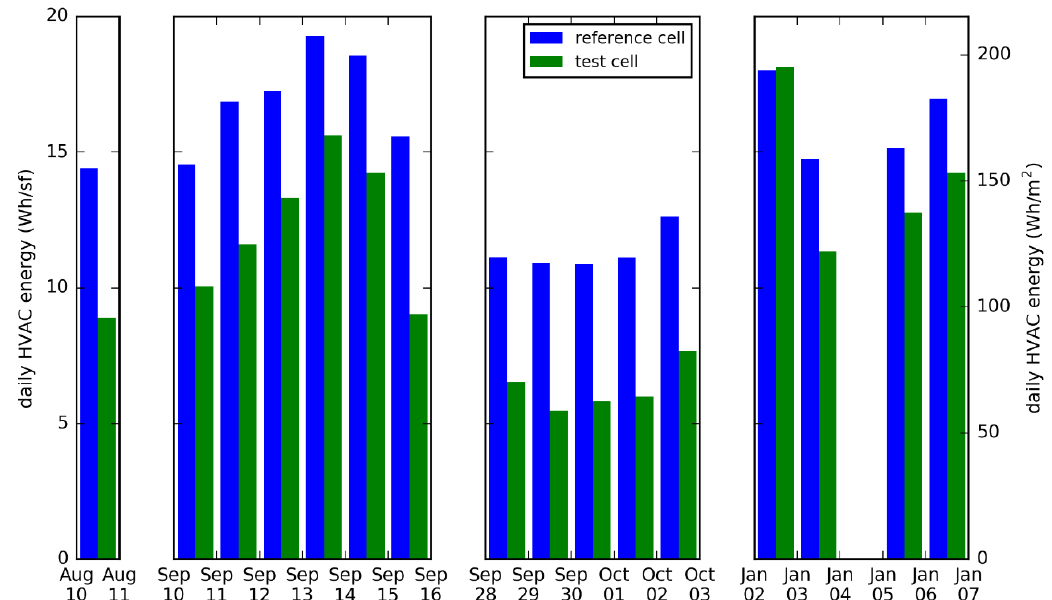
Figure 10. Daily HVAC energy (including chiller system, boiler system, air handlers) for test and reference cells for test days in the Core-S configuration.